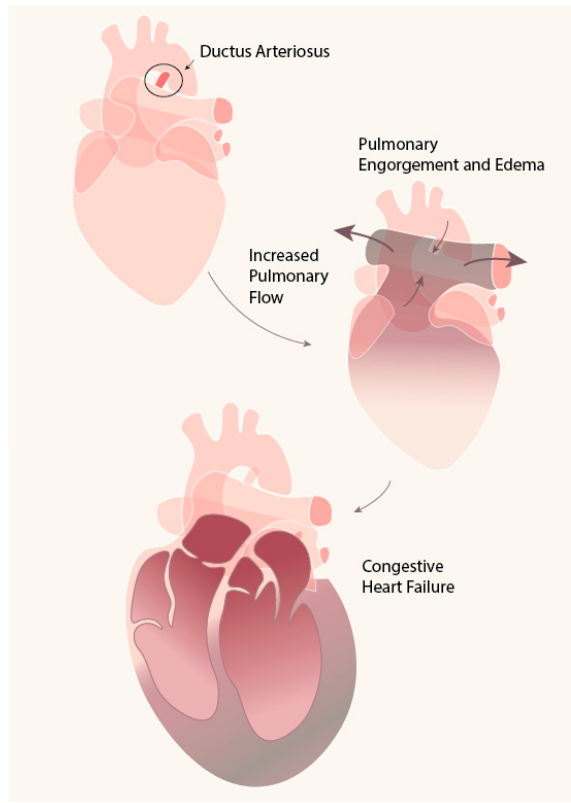
Figure 1. Pathophysiology of hemodynamic burden in patent ductus arteriosus (PDA). Blood from the high-pressure aorta shunts to the low-pressure pulmonary artery, causing pulmonary hyperemia.